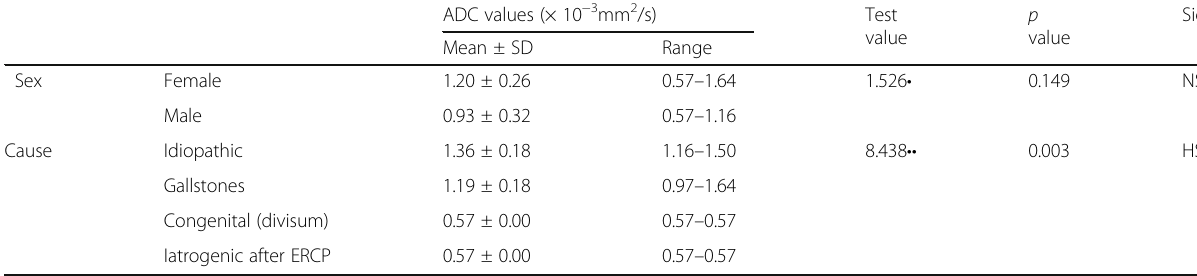
Table 4 Relationship between sex/cause and mean ADC value in the patient group